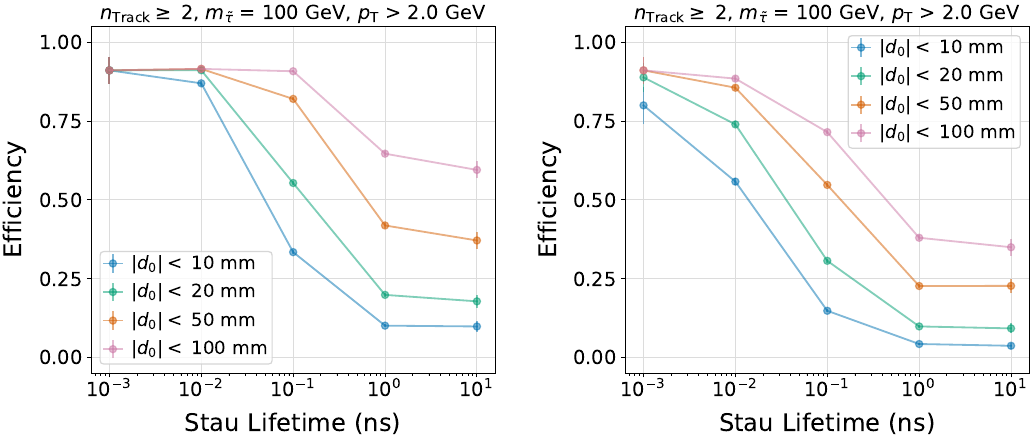
Figure 14. Event-level efficiency as a function of stau lifetime for a m ˜ τ = 100 GeV stau. (Left) Assumes 100% efficiency up until a | d endpoint. (Right) Efficiency decreases linearly from 100% 0 | for prompt tracks to 0% at the | d endpoint. In both cases, a minimum track p 0 | minimum track | d | of 1 mm are 0